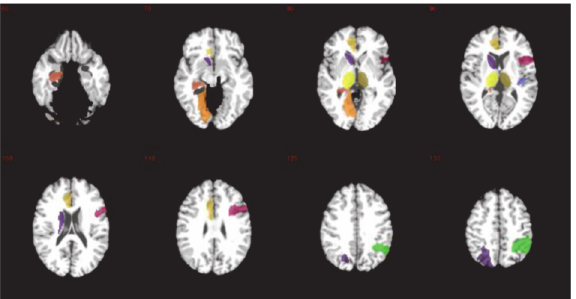
Fig 5. The 15 most frequently selected brain areas by the proposed method. Colors mainly show different